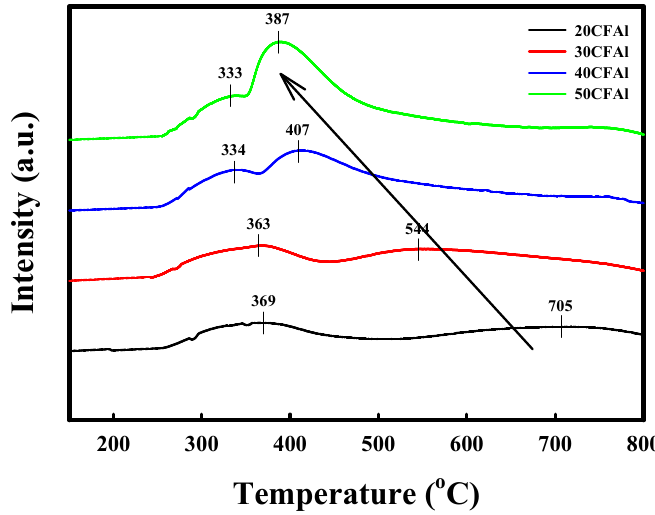
Figure 2. H 2 -TPR profiles of CFAl with different metal loadings. The FT-IR spectra of the CFAl catalysts in the calcined and reduced states were analyzed to determine the reason for the enhanced reducibility of the CFAl catalysts at high metal loading amounts. The IR spectra of the calcined CFAl catalysts contain an absorption band at 3390 cm − 1 , indicating the − OH stretching vibrations. The absorption band at ~1618 cm − 1 corresponds to the vibration of H 2 O molecules. The transmission bands at 1361 and 1483 cm − 1 are due to the carbonyl group of the carboxylate ions, which may remain adsorbed on the surface of Al 2 O 3 during precipitation. The peaks between 778 and 850 cm − 1 are associated with the metal–Al spinel. This result agrees with the result of the XRD analysis. Contrary to the results of the XRD analysis, the metal–oxygen vibration was observed at 400–600 cm − 1 in addition to the spinel phase. With an increasing metal loading, the band intensity of the metal–Al spinel sharply reduced, because a relatively high metal content leads to a low ratio of the spinel-like phase [21,23]. Contrarily, the adsorption bands at 400–600 cm − 1 , corresponding to the metal–oxygen vibrations, did not change. Figure 3b shows the FT-IR spectra of 20CFAl and 40CFAl catalysts after reduction at 500 ◦ C; the results of the catalysts in calcined states are depicted for comparison. As shown in Figure 3b, the metal–Al spinel changed rarely at both the 20CFAl and 40CFAl catalysts after reduction at 500 °C. For the 40CFAl catalyst, however, the adsorption bands of metal–oxygen decreased considerably compared to the 20CFAl catalyst, indicating that the metal oxide was easily reduced. At a low metal content, the catalysts mainly com- prised a spinel form, which was not easy to reduce, as mentioned above. Conversely, the catalysts comprised the high ratio of metal oxides (Co or Fe) to spinel phase. Therefore, it can be concluded that the enhanced reducibility of CFAl catalysts at high metal loading was due to the high ratio of metal oxides to the spinel phase.